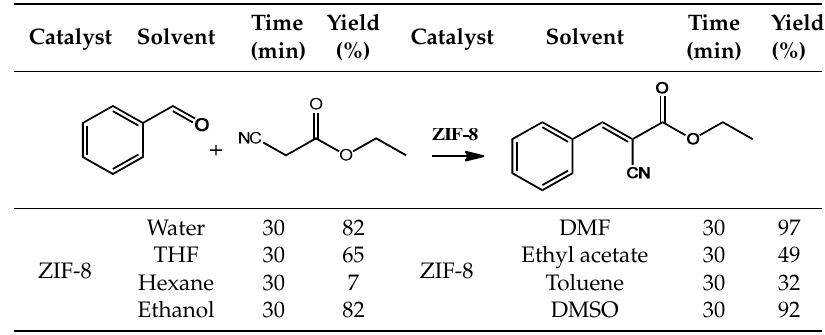
Table 1. Knoevenagel condensation between benzaldehyde and ethyl cyanoacetate in various solvents in the presence of ZIF-8.